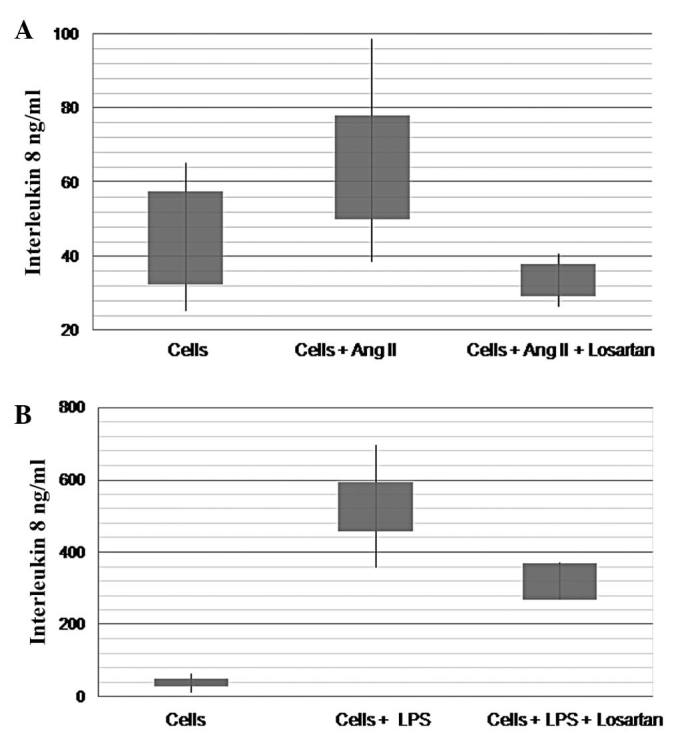
Box plots presenting range of values (boxes) and 95% confidence interval of means (lines) of interleukin 8 concentration in supernatant prior to and following treatment with (A) angiotensin II (Ang II) or Ang II plus losartan and (B) bacterial lipopolysaccharide (LPS) or LPS plus losartan. Cells represent the naïve state. Presented results refer to treatment with 10 ng/ml LPS, 10 μM of Ang II and 100 μM of losartan. All results were obtained 24 h post treatment.